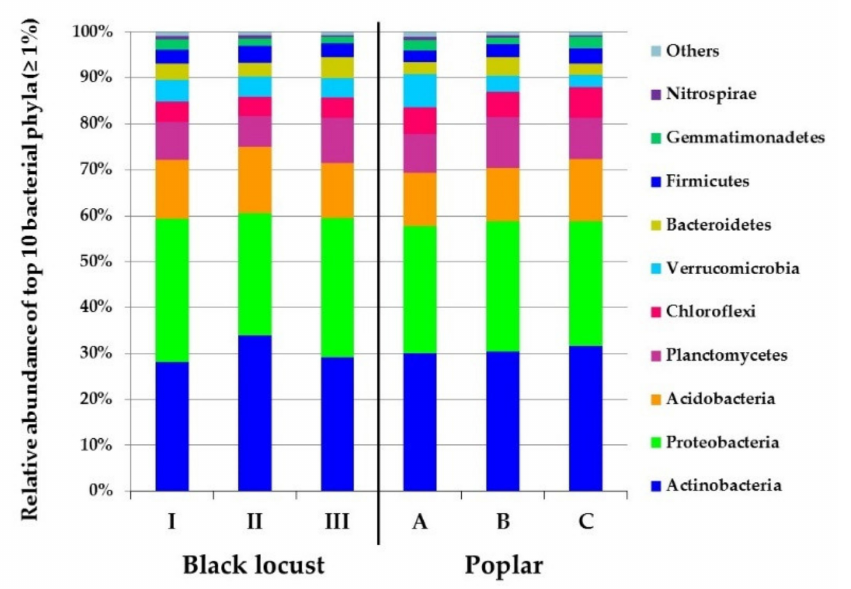
Figure 3. The relative abundance of top 10 bacterial phyla in the soil of black locust and poplar plantation by treatments; control (I—black locust; A—poplar), fertilizer (II—black locust; B—poplar) and arbuscular mycorrhizal (III—black locust) and ectomycorrhizal (C—poplar) treatment. The rhizosphere bacterial community of poplar plantations was dominated by Acti- nobacteria (30.71%), Proteobacteria (27.74%) followed by Acidobacteria (12.19%), Planc- tomycetes (9.50%), Chloroflexi (6.03%), Verrucomicrobia (4.47%), Bacteroidetes (3.04%), Firmicutes (2.86%) and Gemmatimonadetes (2.02%). The relative abundances of